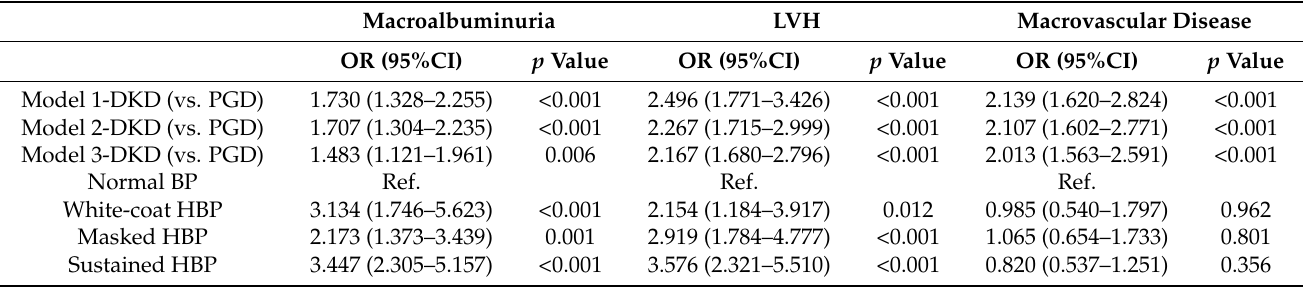
Table 3. Association between different groups, blood-pressure patterns and target-organ damage using logistic regression analysis. ( n = 1002).